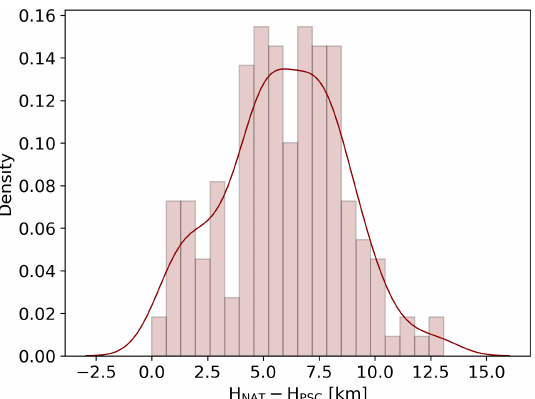
Figure 10. Distribution of the thickness of the stratospheric do- main satisfying T < T NAT unoccupied by PSC layers, in km, on days when a PSC is detected at